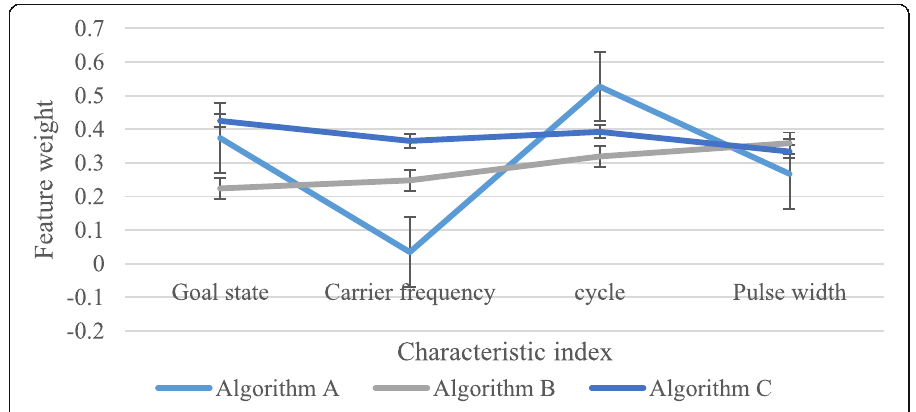
Fig. 3 Comparison of absolute error and operation time of the three